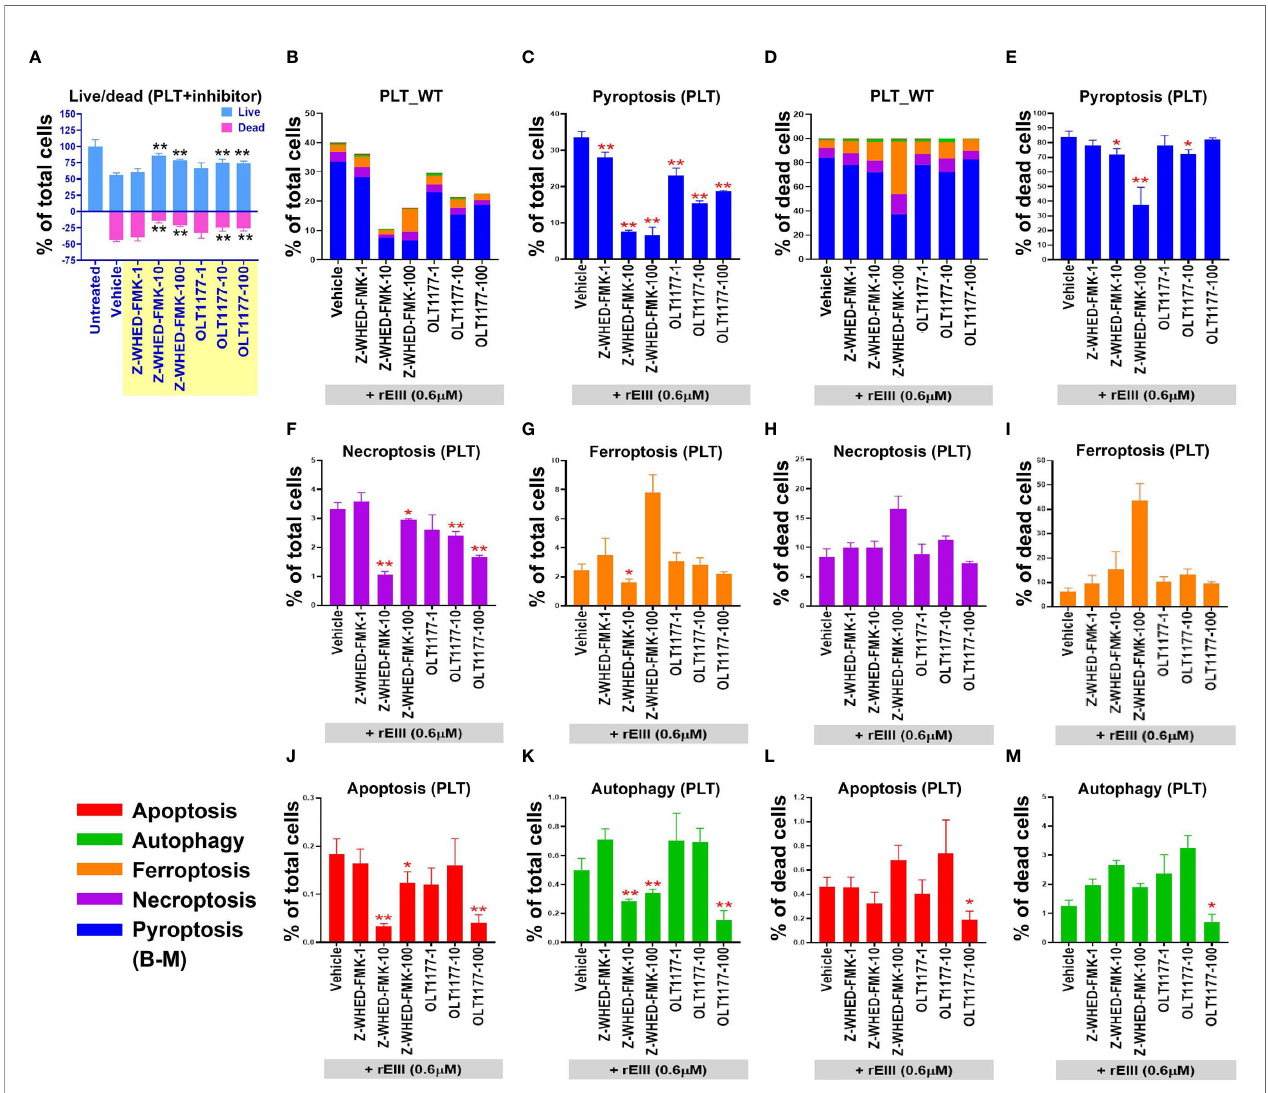
FIGURE 4 | Treatment with Nlrp3-in fl ammasome inhibitors protects wild type (WT) mouse platelets (PLT) from DENV- (equivalent to 0.6 m M rEIII) and rEIII (0.6 m M)- induced pyroptosis. Treatment with Nlrp3 inhibitor OLT1177 (100 m M) and caspase 1 inhibitor Z-WHED-FMK (100 m M) rescued rEIII-induced platelet cell death (A) . Treatments with both OLT1177 and Z-WHED-FMK rescued % of RCDs (B, C, F, G, J, K) . Intriguingly, if we normalize the respective RCD % by the population of death cells ( D ; dead cell population normalized to 100%), we found that OLT1177 and Z-WHED-FMK preferentially rescued (E) pyroptosis, (H, I, L, M) but not the other tested RCDs. n = 6, * P < 0.05, ** P < 0.01 vs. vehicle